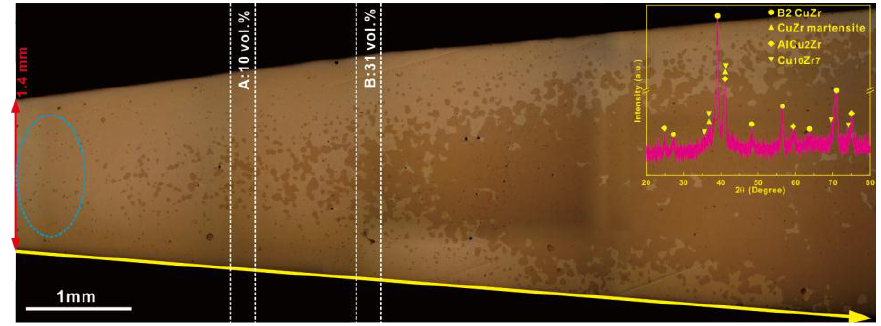
Figure 3. OM image of the as-quenched (Cu 0.5 Zr 0.5 ) 84 Al 10 Co 6 BMG composites with a wedge-shape.